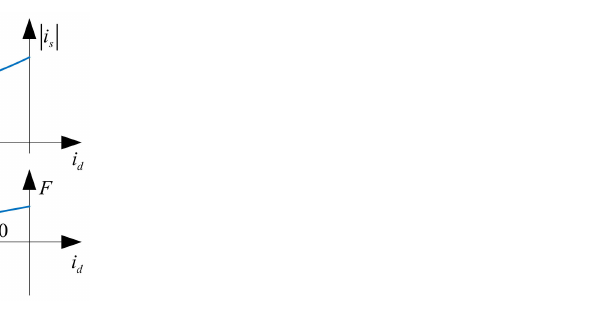
Figure 1. Schematic diagram of the typical i d − | i s | and i d − F curves under a constant torque.